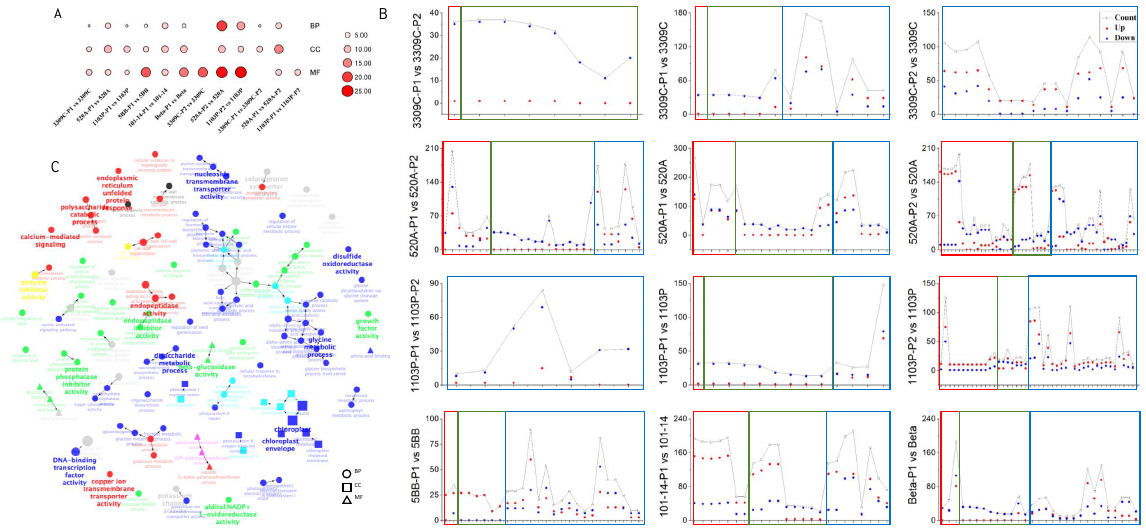
Figure 2. Comparisons of the statistical overrepresentation of GO categories of the three rootstock groups under salt stress. ( A ) Comparison of the total of the three categories of GO enrichment between tolerant and intolerant varieties. ( B ) Comparison of the GO enrichment of tolerant and intolerant varieties. The specific GO terms represented by the abscissa are described in Table S3. The red box represents biological processes (BP), the green box represents cellular components (CC), and the blue box represents molecular functions (MF). ( C ) Visualization of the regulatory network based on the GO analysis results in GO Levels 5–8. The different GO categories are colored according to the correlation between the three groups as shown by the Venn diagram; gray indicates that a term is only enriched but has no specific clusters. Ellipses, squares, and triangles represent biological processes, cell components, and molecular functions, respectively. The size of the shape indicates the number of genes contained in